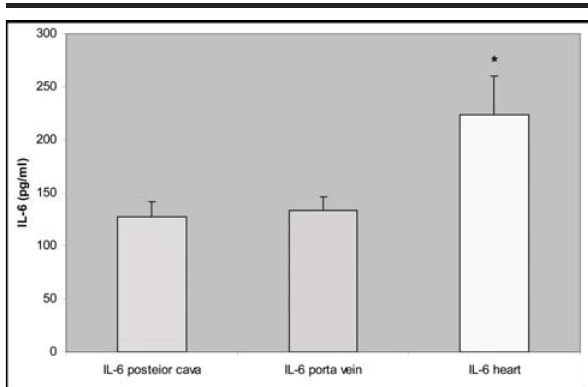
FIGURE 2 - Serum IL-6 level in the three collection sites. Data express the mean and the SEM*, p<0.01 versus both portal and posterior cava